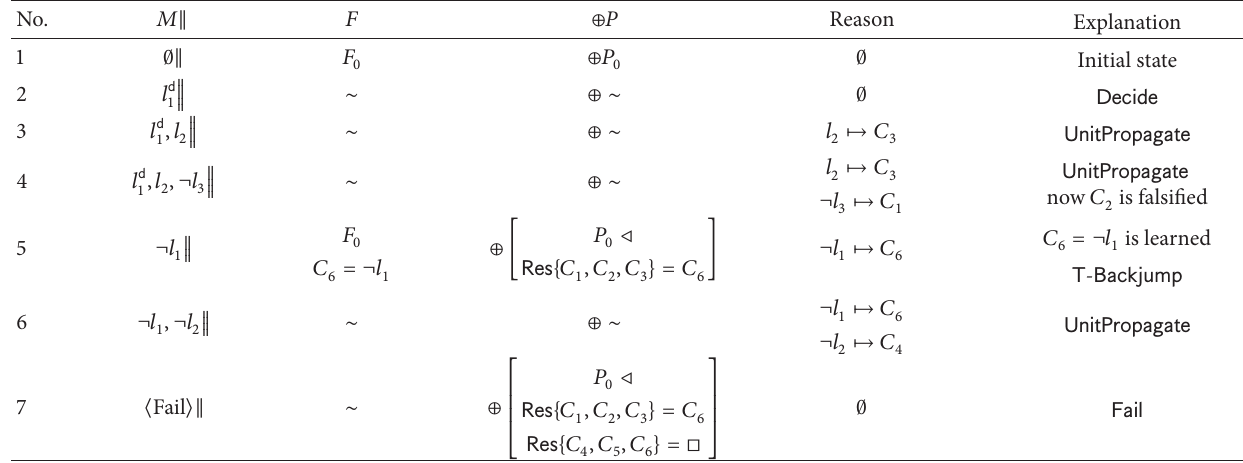
Table 2: The CDPLL( T ) procedure for Example